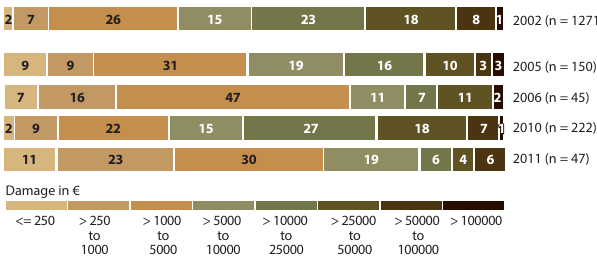
with regard to household contents). This pattern can only be explained by taking into account several factors, e.g.